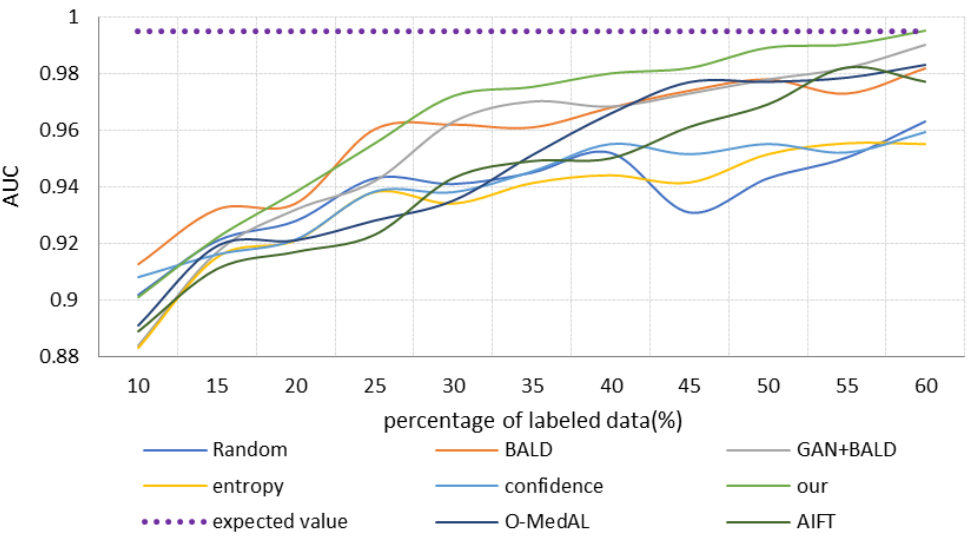
Figure 7. AUC with the increase of iterations. Figure 8 is the relationship between the accuracy of different strategies and samples.